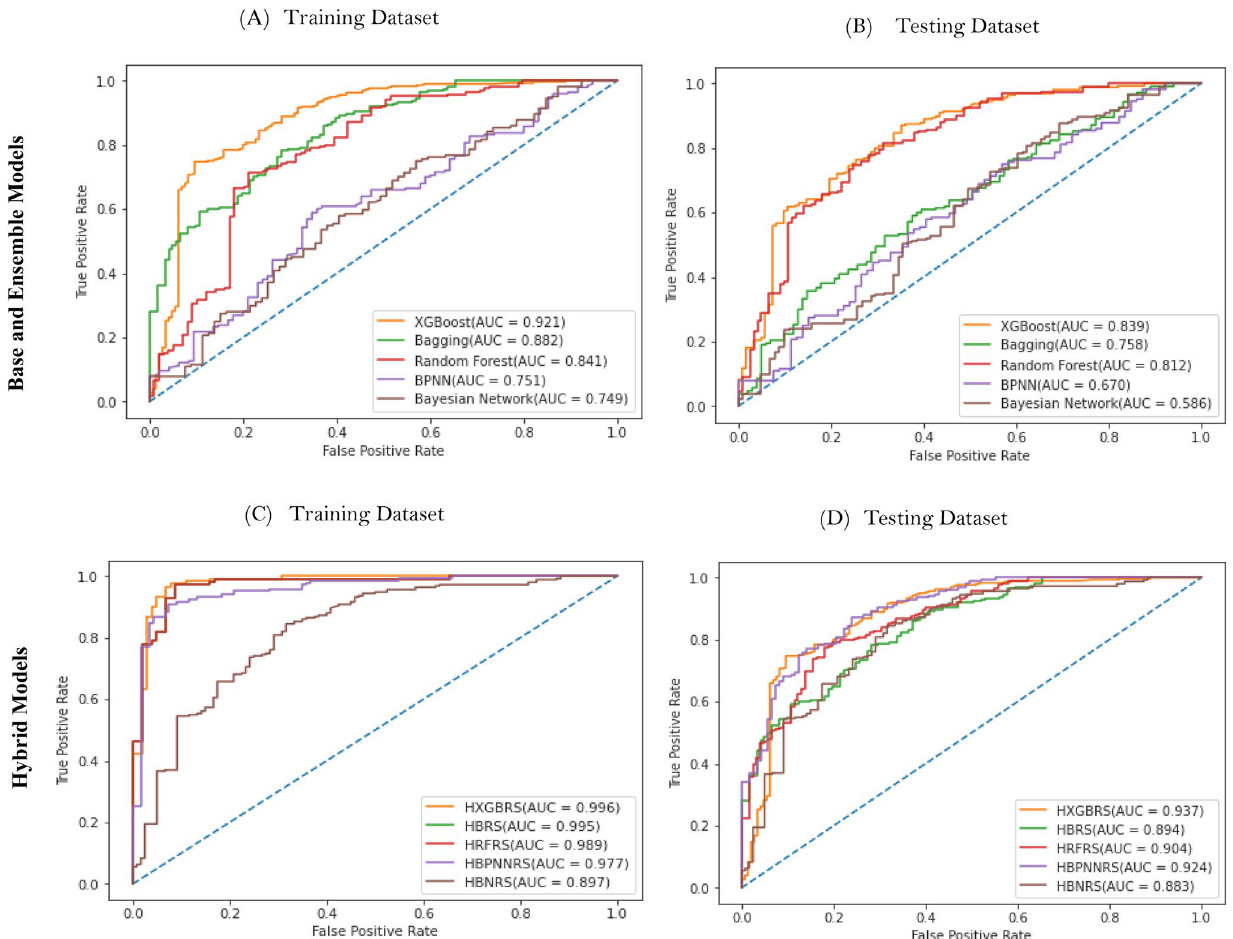
Figure 8. ROC curves used to analyze the prediction capability of various base, ensemble and hybrid landslide prediction models. ( A ) and ( C ) represents the performance for training dataset, ( B ) and ( D ) represents the performance for testing dataset.